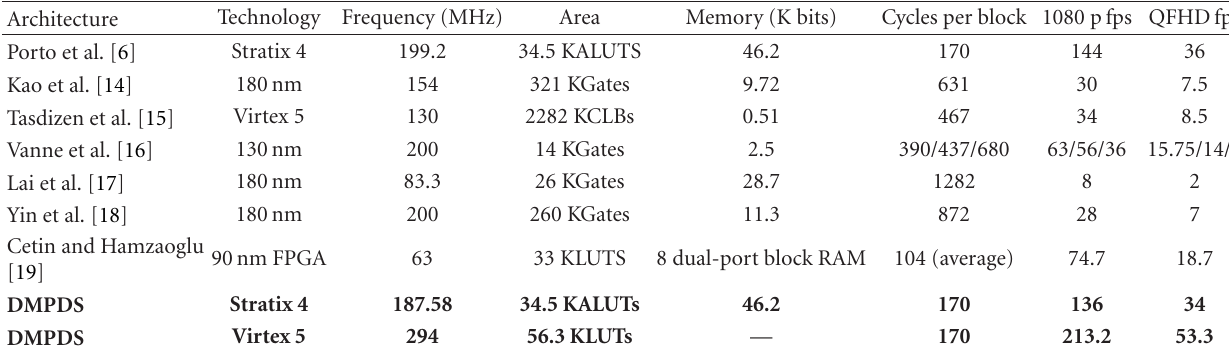
Table 4: Synthesis results and